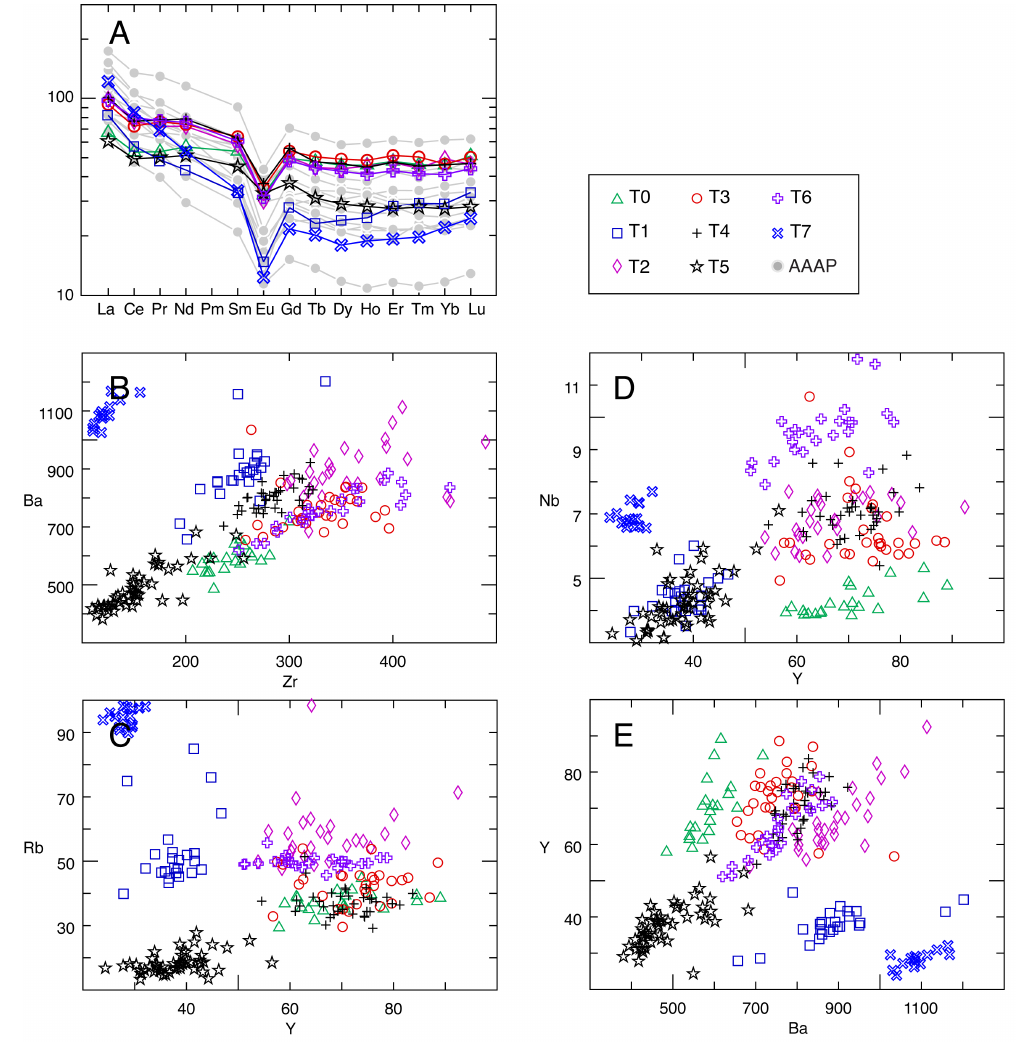
Figure 6. Plots of the trace-element composition of single glass shards for T0–T7. (A) Spider diagram comparing the average REE abun- dances of each tephra to known AAAP (Aleutian Arc–Alaska Peninsula) Pleistocene tephra (Pearce et al., 2004b; Preece et al., 2011a, b; Jensen et al., unpublished data). Data are normalized to chondrite after Sun and McDonough (1989). (B–E) Plots of trace elements that allow differentiation between each tephra. (B) Zr-Ba, (C) , Y-Rb (D) , Y-Nb (E) Ba-Y. Tephras T1, T5 and T7 are compositionally distinct, and can be clearly separated based on a combination of Ba, Rb, Zr and Y ( B and C ). T0 and T6 form separate clusters when compared on their Y and Nb concentrations (D) . T2, T3 and T4 are more similar, but T3 shows a lower Zr/Ba ratio than T2 and T4 (B) , and these 3 samples all display different Ba/Y ratios (E) , which can be used to separate